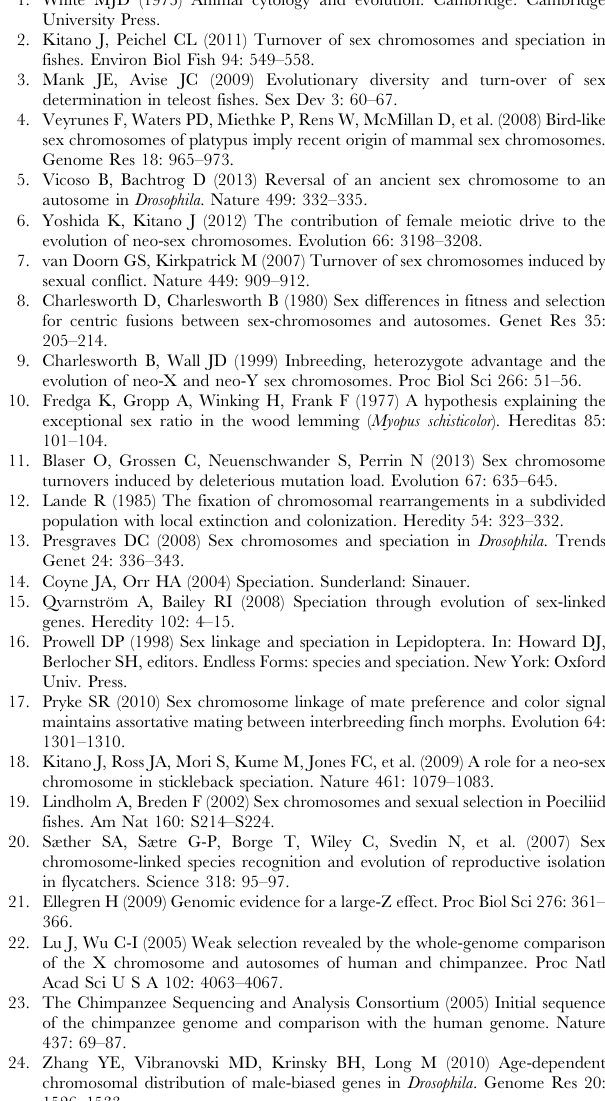
Table S3 Tests of species differences in morphological traits